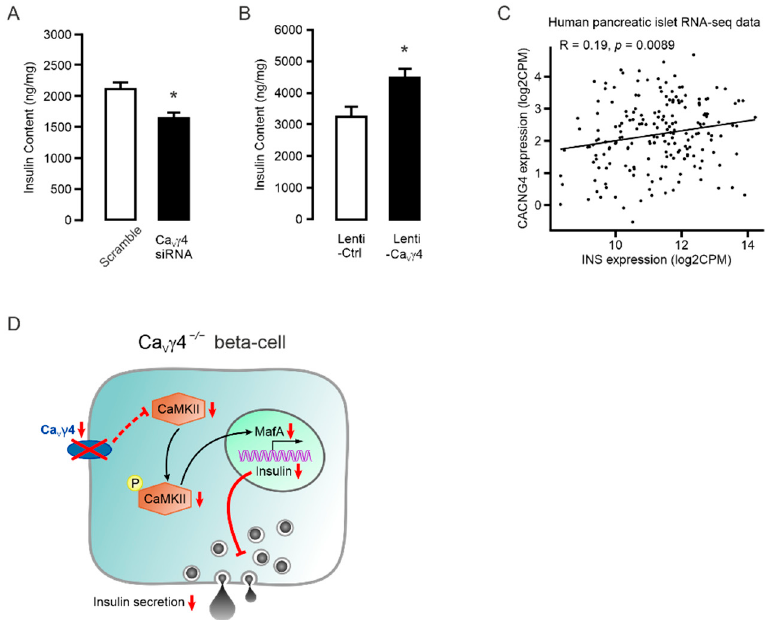
Figure 4. Ca V γ 4 regulates insulin production in beta-cells: ( A ) Reduced insulin content in Ca V γ 4- silenced INS-1 832/13 cells. n = 4, * p = 0.014. ( B ) Increased insulin content in Ca V γ 4-overexpressed INS-1 832/13 cells. n = 4, * p = 0.035. ( C ) Pearson correlation performed between the log2-transformed normalized expression values of CACNG4 and INS in Counts Per Million (CPM). n = 188 human donors. ( D ) Schematic model of cascading effects from Ca V γ 4 deletion through CaMKII expression to insulin secretion in Ca V γ 4 − / − beta-cell. See main text for details. Data are presented as Mean ± SEM and were analyzed with two-tailed unpaired Student’s t -test.